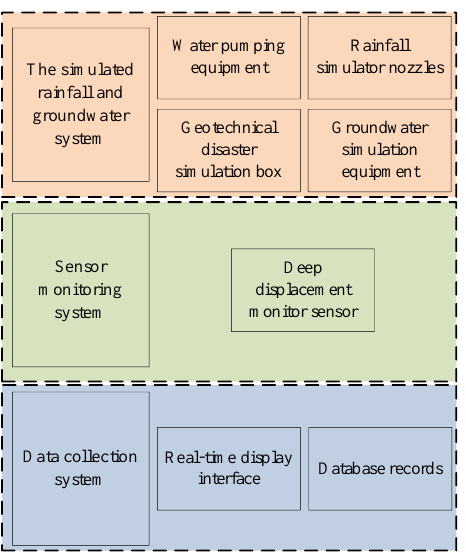
Figure 1. Schematic diagram of the framework of the landslide experiment equipment.